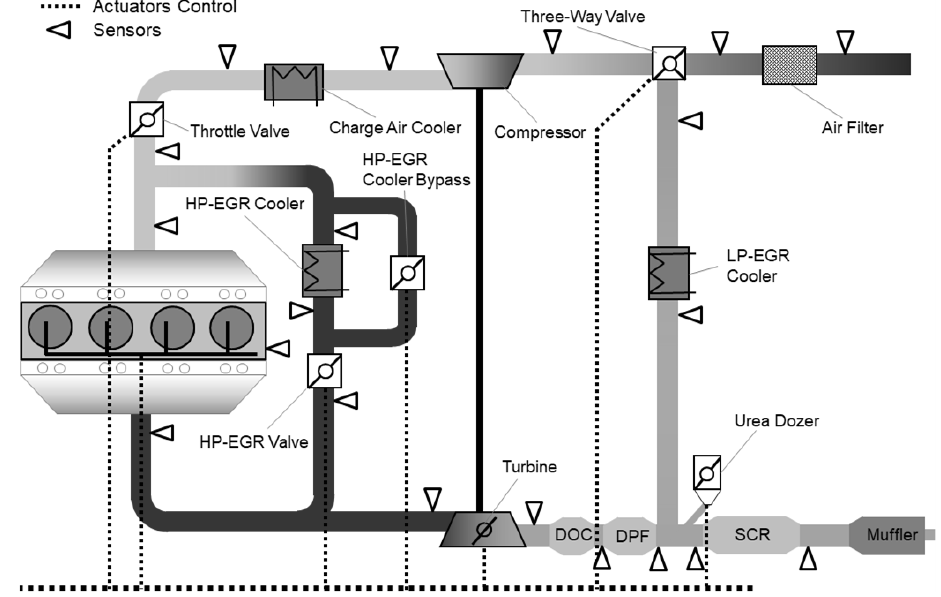
Figure 1. Schematics of the model CI diesel engine.